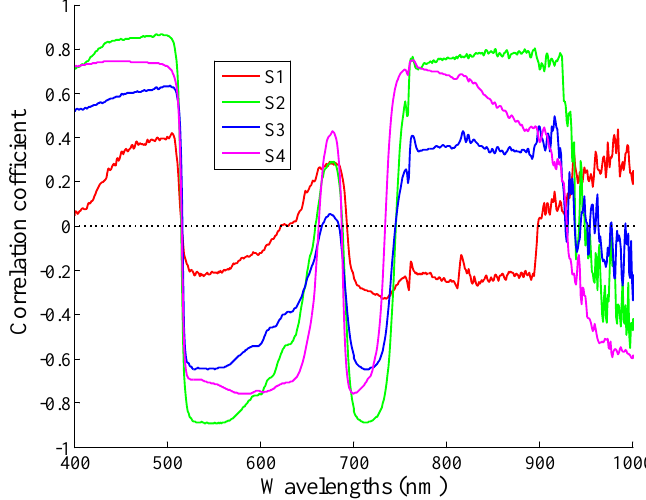
Figure 4. Correlation coefficient curve between chlorophyll content and reflectance spectra.